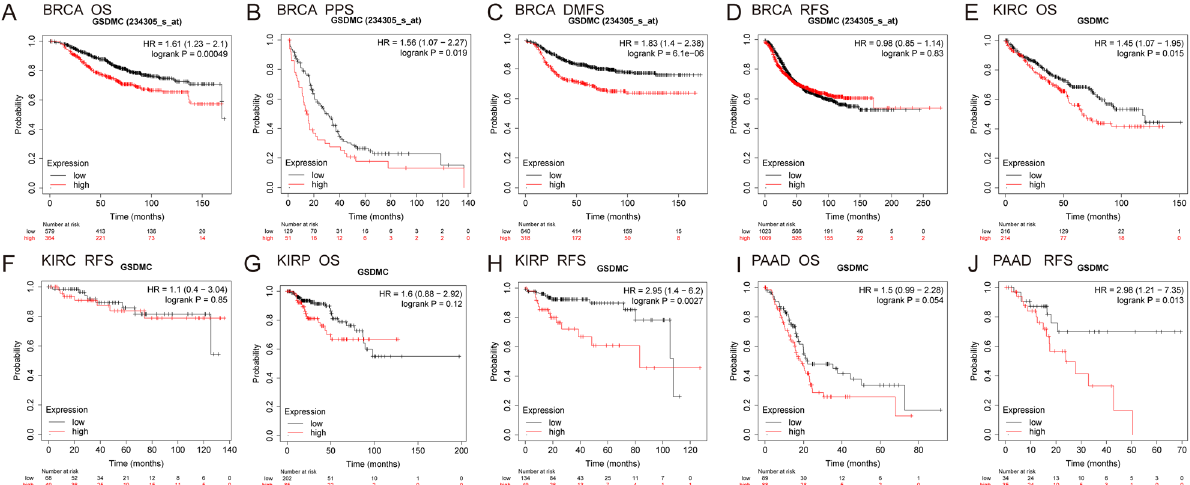
Figure 6. Kaplan–Meier survival curves comparing the high and low expression of GSDMC in different types of cancers in the Kaplan–Meier plotter databases ( A–J ). OS overall survival, DFS disease-free survival, RFS